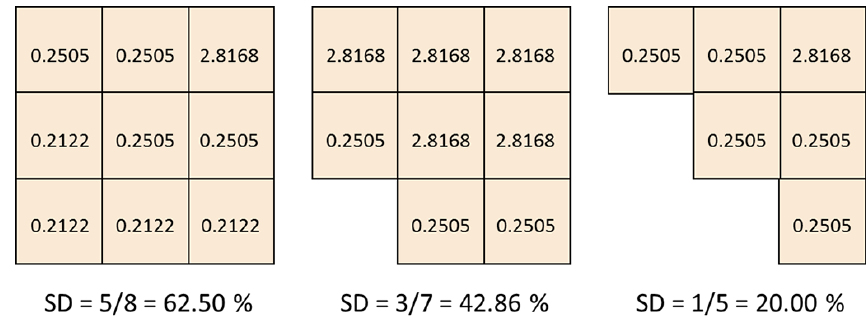
Figure 3. Calculation of the spatial difference (SD) of three center pixels with SD = {number of neighboring pixels with different value} / {number of neighboring pixels}. Table 1. Data used in the Annotto Bay flood risk assessment (Glas et al., 2015).